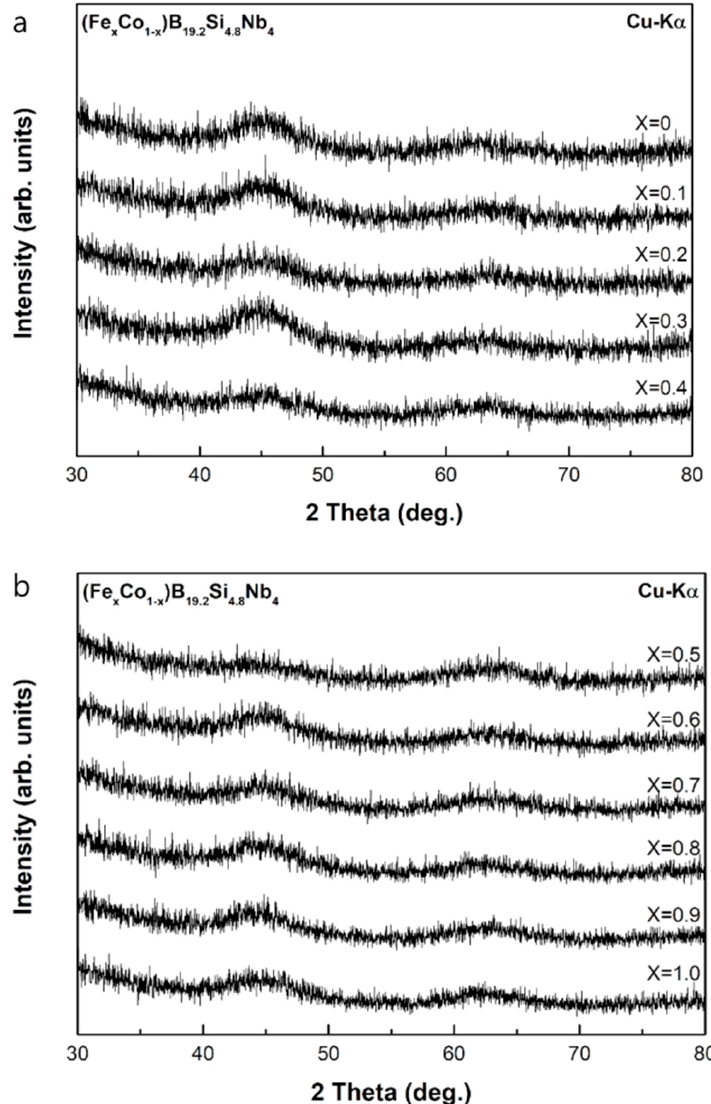
Figure 2. XRD patterns of the (Fe x Co 1 − x ) 72 B 19.2 Si 4.8 Nb 4 as-spun ribbons ( a ) 0 ≤ x ≤ 0.4 ( b ) 0.5 ≤ x ≤ 1.